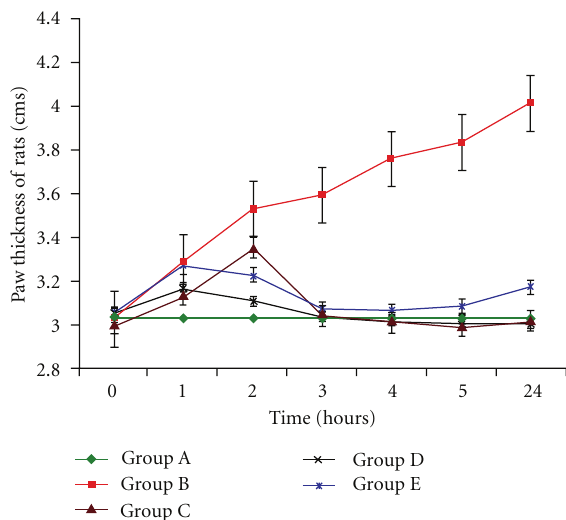
Figure 1: Change in paw thickness (cm) at t = 0,1,2,3,4,5, and 24 hours. n = 5 (significant at P < 0 . 001). Edema was induced by injecting 0.1 mL of 1% solution of carrageenan into the sub plantar surface of right-hind paw. Data are expressed as mean ± standard error of seven rats per group. Group A: carrageenan control; Group B: control; Group C: L. casei fed; Group D: L. acidophilus ; Group E: positive control.